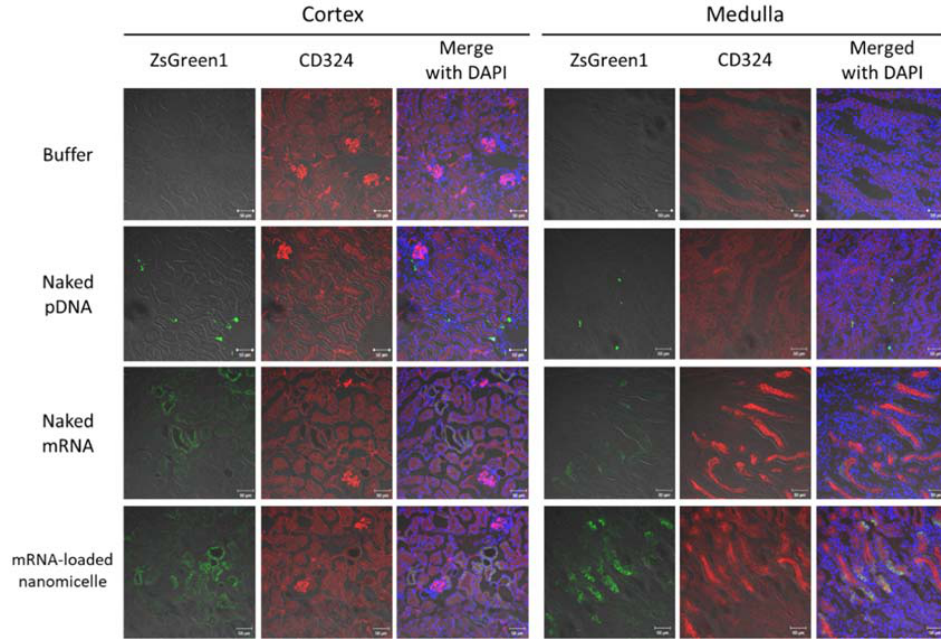
Figure 3. Distribution of ZsGreen1 expression in the kidney following renal pelvis injection. Mice were injected with ZsGreen1 messenger RNA or plasmid DNA by renal pelvis injection. At 24 h after injection, the kidney tissues were histologically analyzed with anti-ZsGreen1 antibody and CD324 (specified for tubular epithelial cells)-antibody staining. The stained sections were observed by confocal laser scanning microscopy. Objective lens: ×40 lens. Green: ZsGreen1 expression; Red: CD324; Blue: DAPI. Scale bars represent 50 µm.